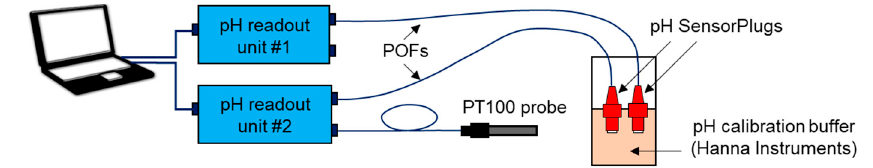
Figure 4. Setup used for the single point calibration of PreSens pH SensorPlugs.